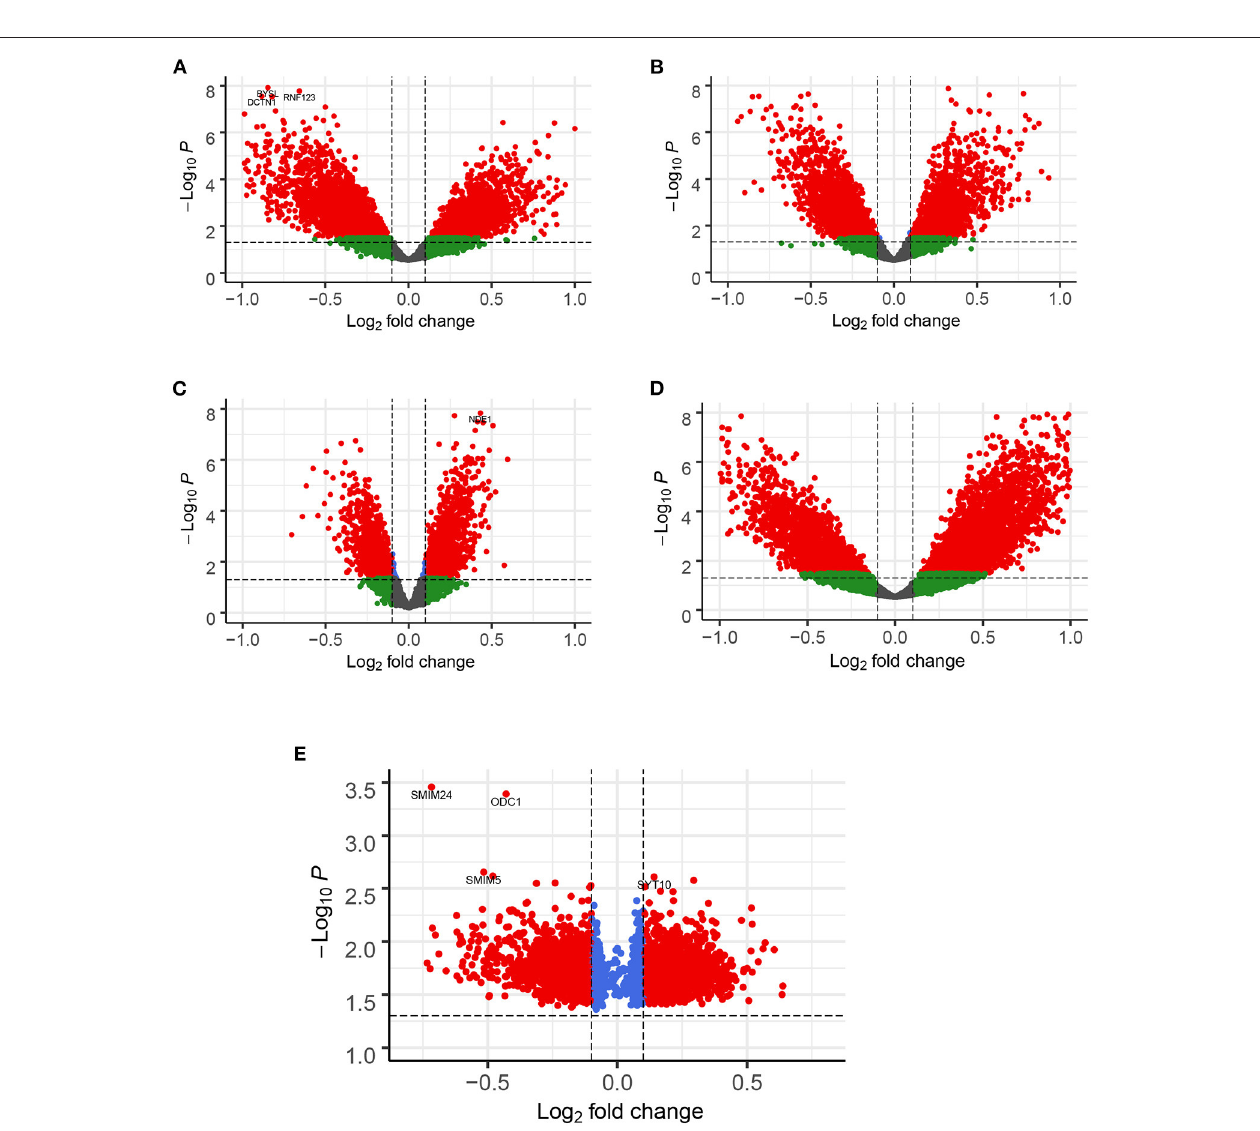
FIGURE 2 | Enhanced Volcano for illustrating DEGs in all datasets. The gene with | logFC | > 0.1 and FDR < 0.05 as DEGs shown in red node. (A) EC, (B) HP, (C) FC, (D) TC and (E) ADNI. Note: in ADNI dataset, DEGs by counting the frequency of 3 or above out of 10 occurrences.